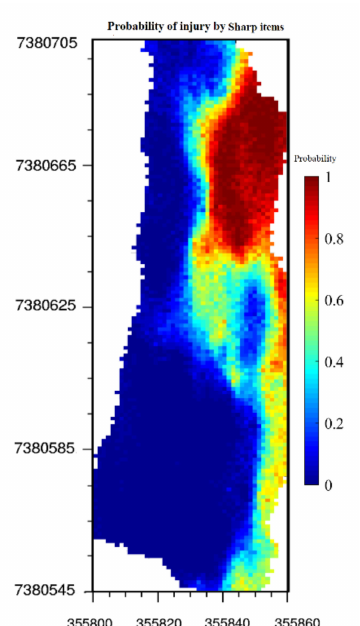
Figure 10. Map of the probability of injury by sharp items calculated on the basis of hundred generated